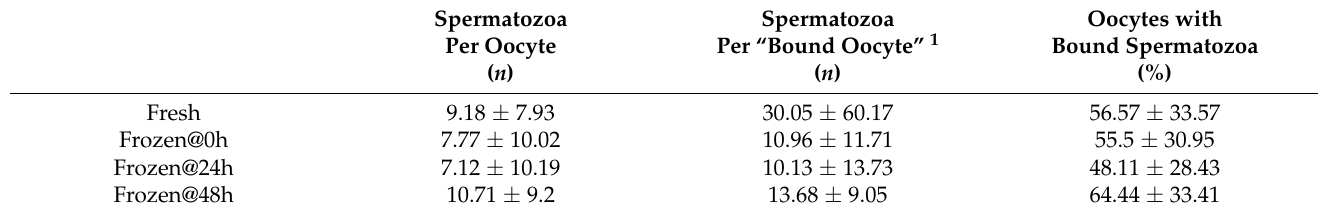
Table 3. Ability of ejaculated canine spermatozoa to bind homologous zonae pellucidae at collection (Fresh), after standard freezing (Frozen@0h), or freezing at different times of storage in a transport box (Frozen@24h and Frozen@48h).